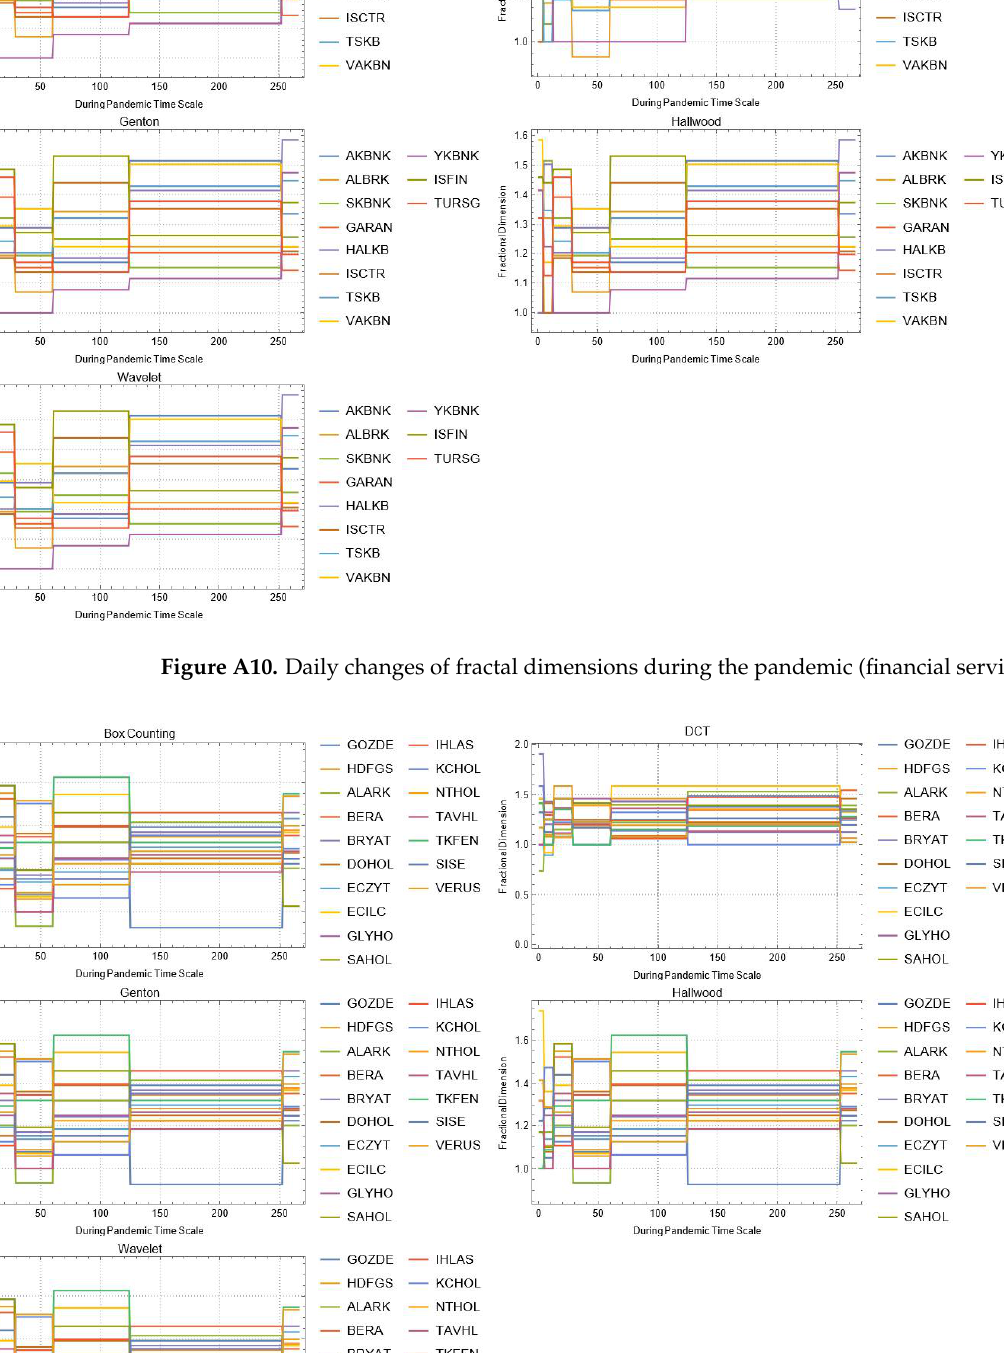
Figure A9. Daily changes of fractal dimensions during the pandemic (mining).